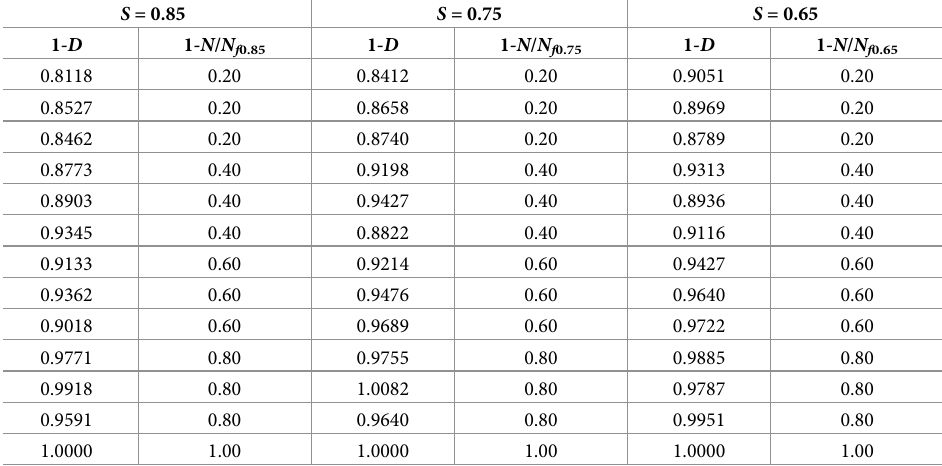
Table 10. Damage evolution equation test under different stress